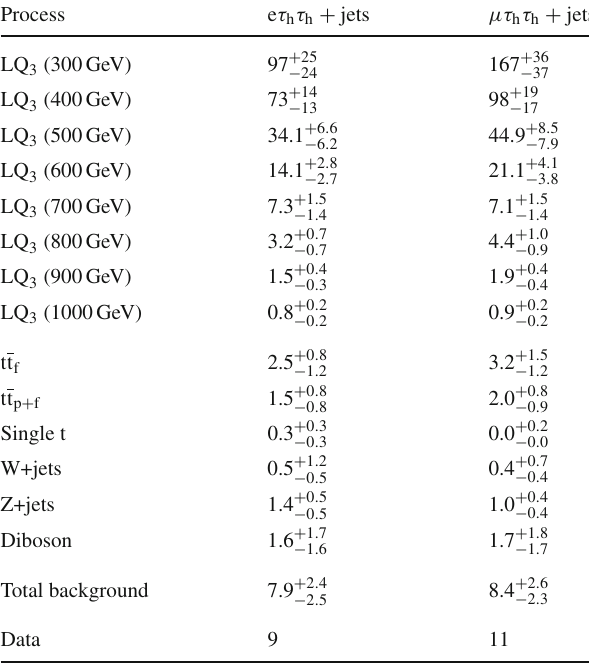
Table 3 Final event yield in category B in the muon and electron chan- nels for different leptoquark mass hypotheses, the background pro- cesses, and data. The total uncertainties for the signal and the back- ground processes are shown Process